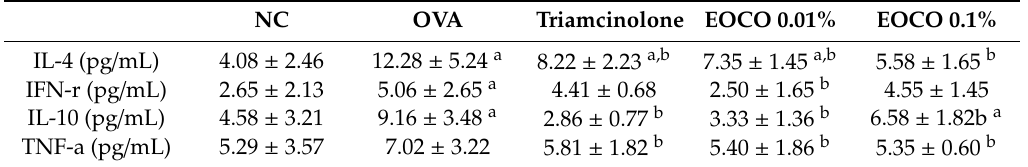
Table 1. Effects of essential oil from Chamaecyparis obtusa (EOCO) on the level of inflammatory mediators in the nasal lavage fluid (NLF) (n = 8 mice per group).